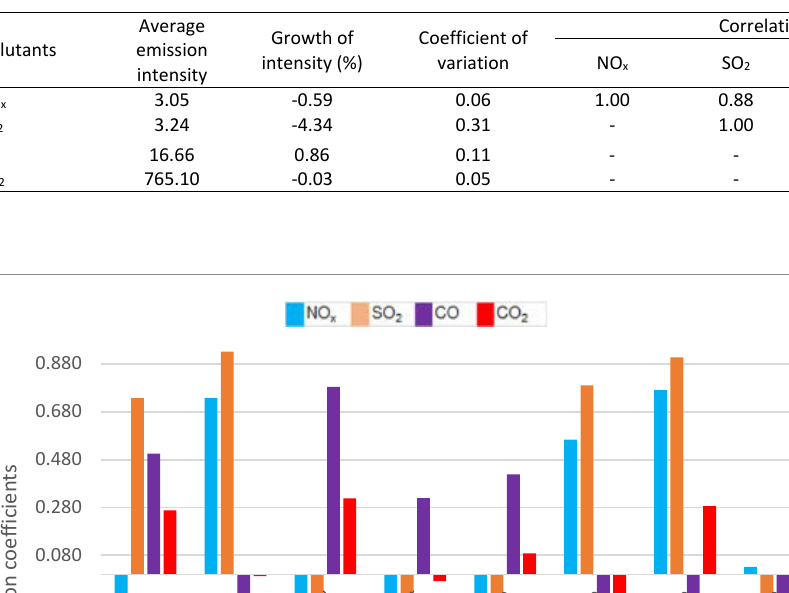
Fig. 4: The schematic structure of the wavelet neural network models Table 1: Descriptive statistics of the selected pollutants